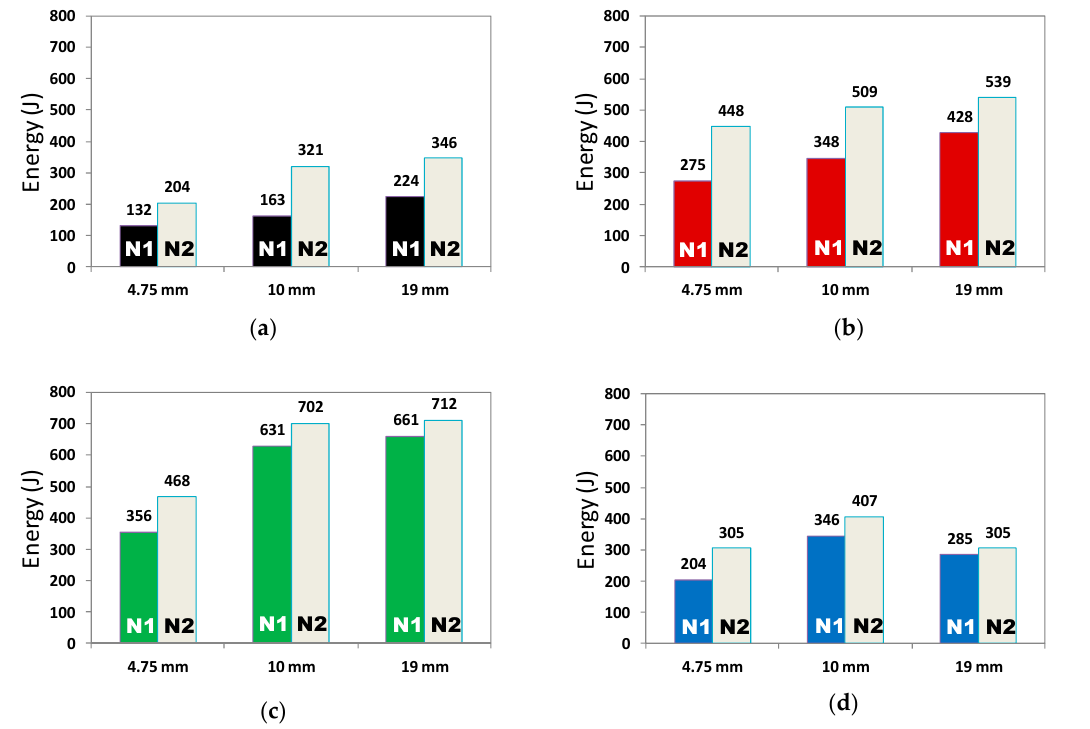
Figure 13. Results of drop weight test on disc specimen ( a ) control specimens, ( b ) with (F) 0.5% fibers, ( c ) with (F-4S) 0.5% fibers and 4% SBR, and ( d ) with (F-8S) 0.5% fibers and 8% SBR.